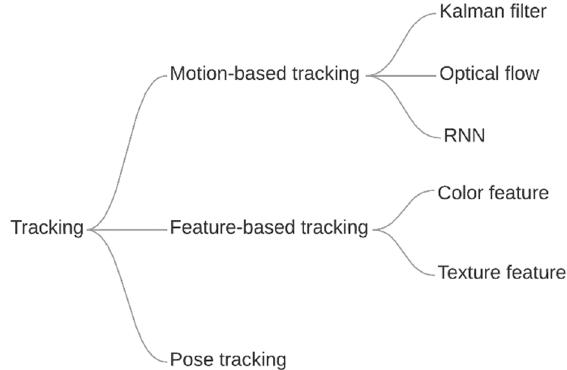
Figure 9. Taxonomy of the tracking methods.